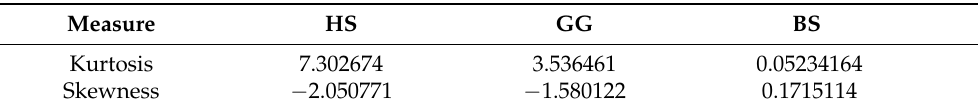
Table 1. Calculated (excess) kurtosis and skewness measures for the three distributions depicted in Figure 1 for the SPY option data.